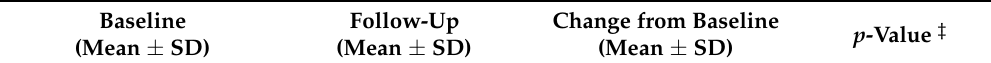
Table 1. Demographic data (N = 53) for the prediction models of the changes in symptom and functioning